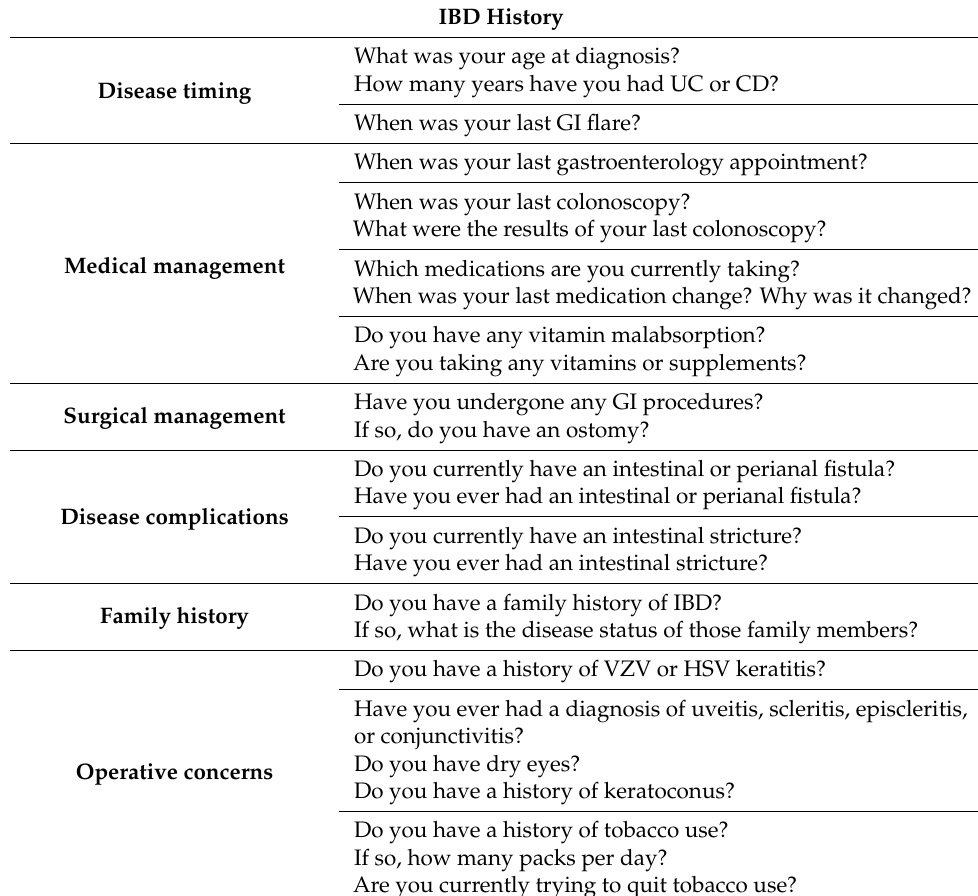
Table 3. IBD history questionnaire. This figure details relevant questions regarding the disease course for a patient with IBD. VZV: Varicella–Zoster virus; HSV: herpes simplex